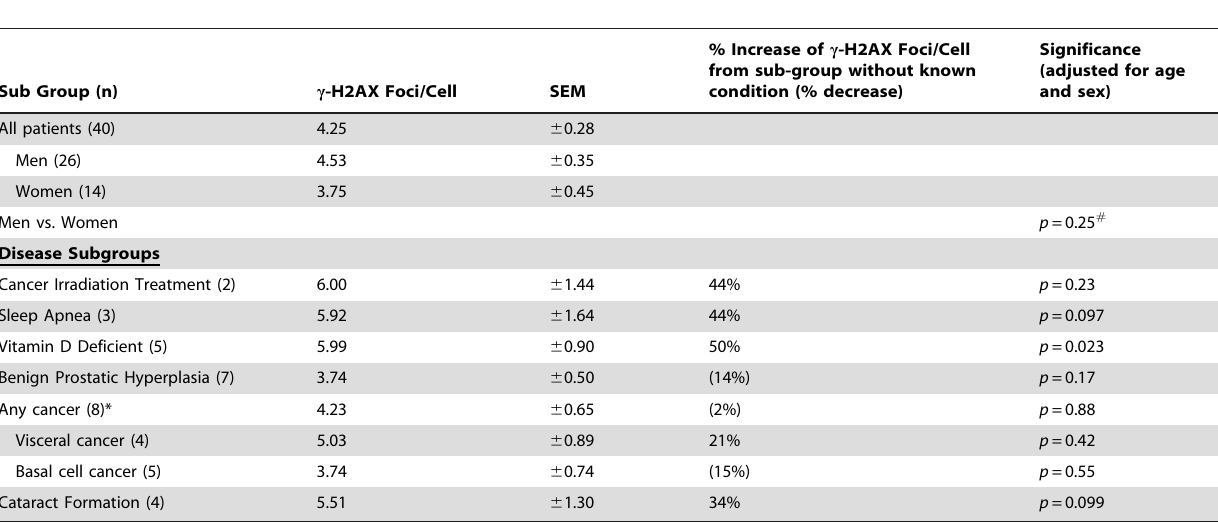
Table 1. c -H2AX foci/cell in human leukapheresis-derived mononuclear cells, stratified by disease subgroups which contribute to oxidative stress and/or DNA damage (with the exception of benign prostatic